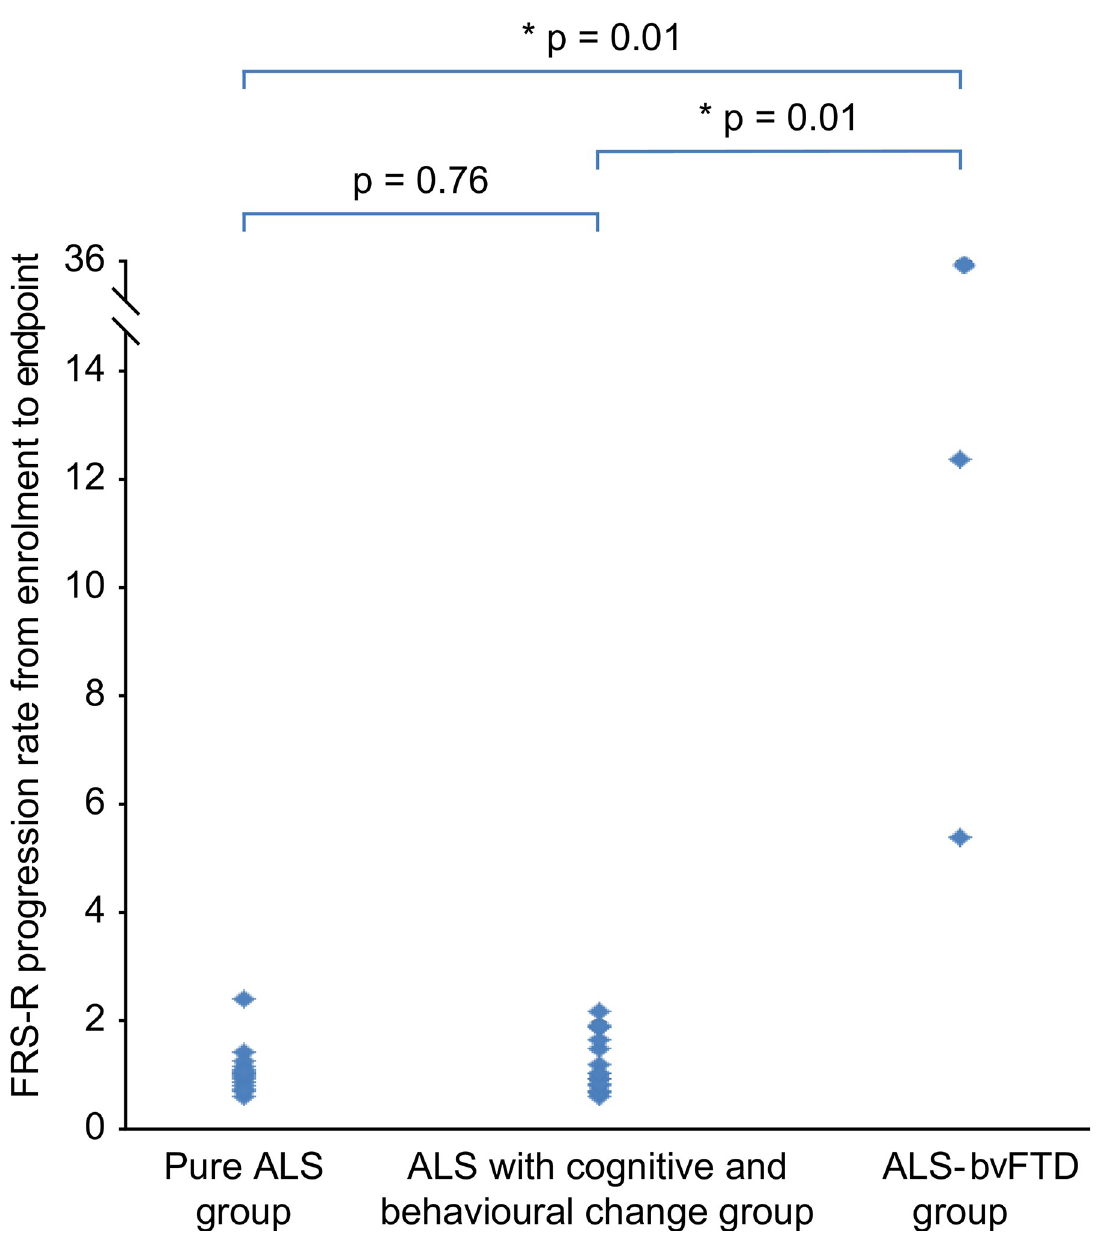
Fig 4. Comparison of FRS-R progression rate from enrollment to death among